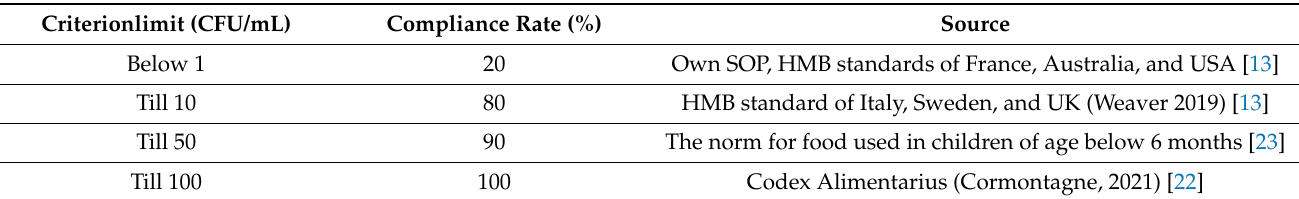
Table 9. Quantitative assessment of the post-pasteurization B. cereus contamination: compliance rate with different microbiological safety